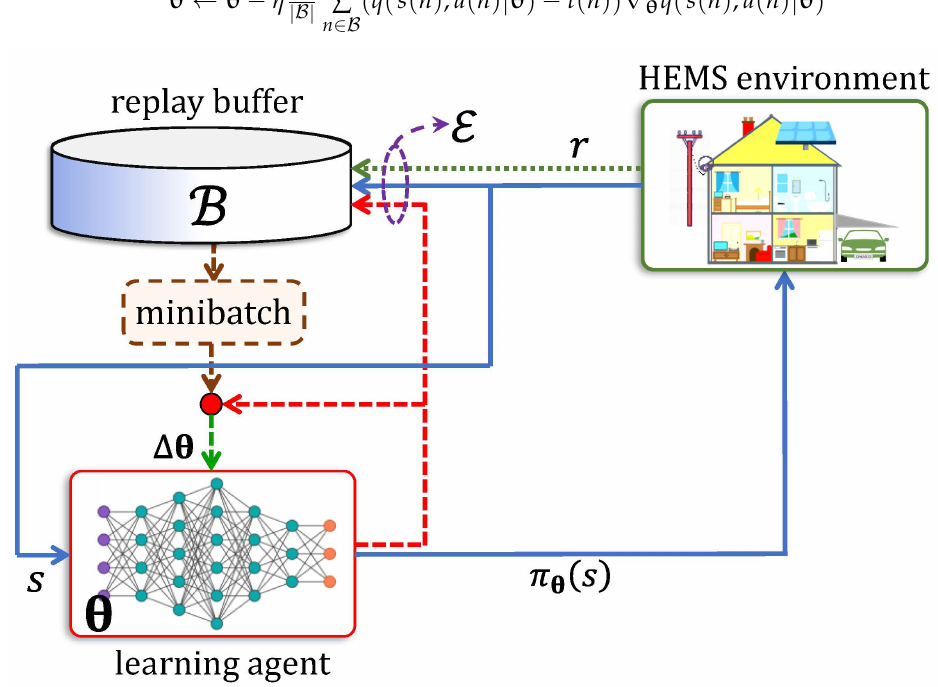
Figure 4. Replay Buffer. Shown are the replay buffer, environment, and agent. The pathways are involved during the agent’s interaction with the environment (solid blue) and training (dashed red). The buffer B is flushed before the next cycle begins with the updated parameter θ